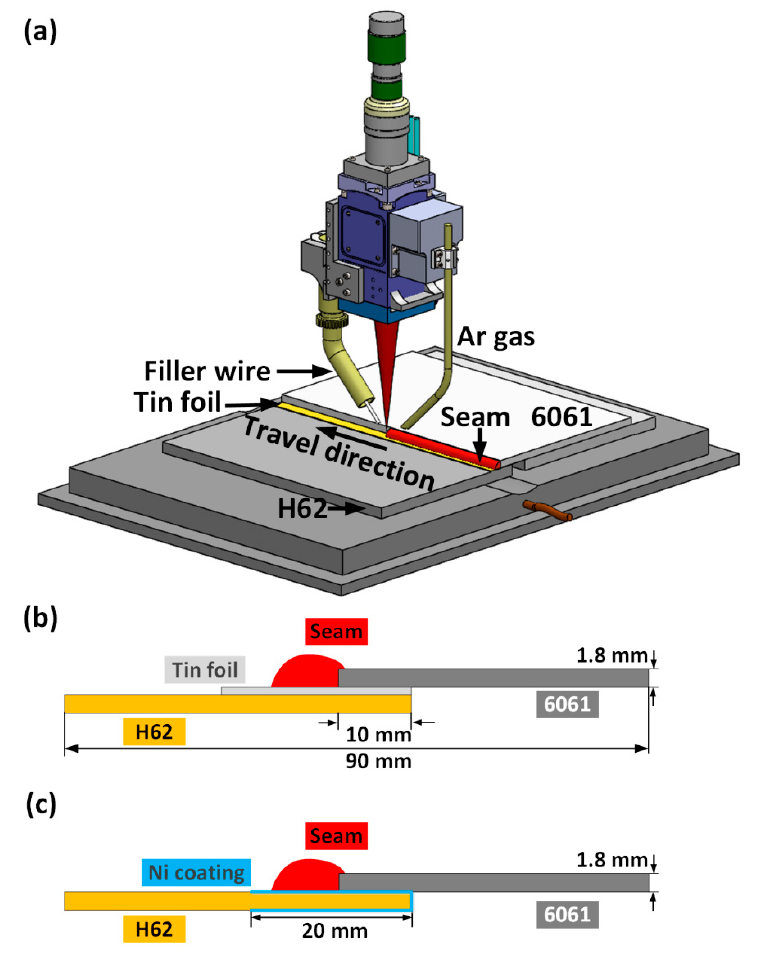
Figure 1. Schematic of LWB Al/Cu dissimilar joints: ( a ) LWB process. Reprinted with permission from Ref. [31] copyright 2021 Elsevier B.V.; ( b ) size and schematic of a lap joint with tin foil; ( c ) size and schematic of an Al/Ni-coated Cu lap Table 1. Chemical compositions of the base metals and the Zn-based filler (wt.%) [7,36].